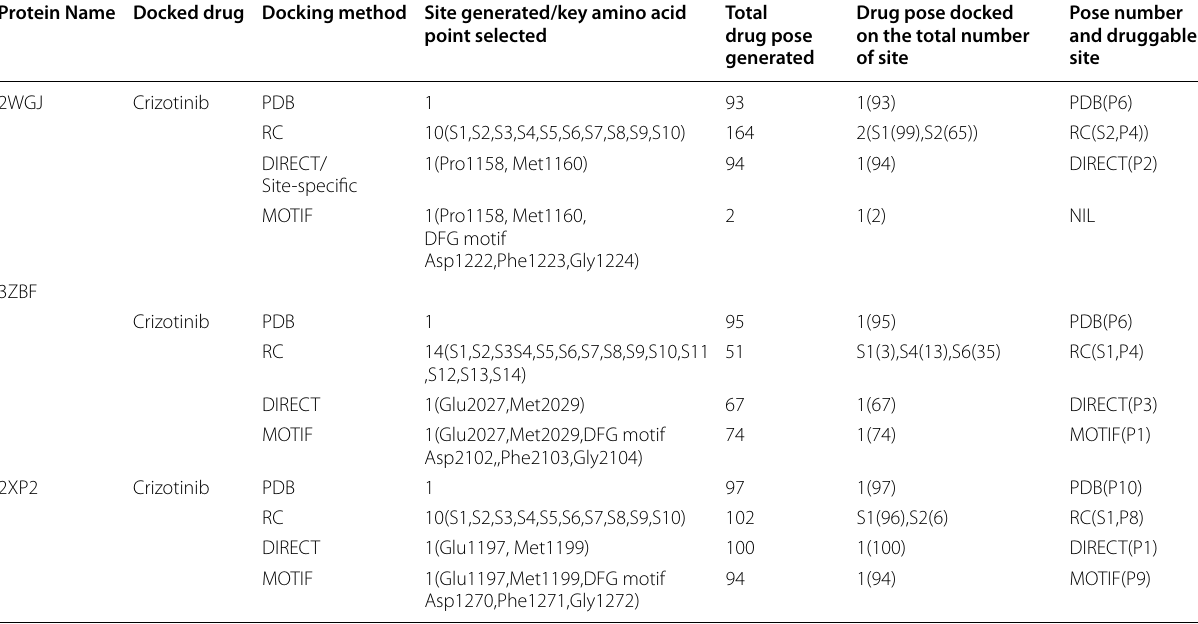
Table 2 Details of the docked drug, total drug pose generated in each docking method and details of the druggable binding site Protein Name Docked drug Docking method Site generated/key amino acid point